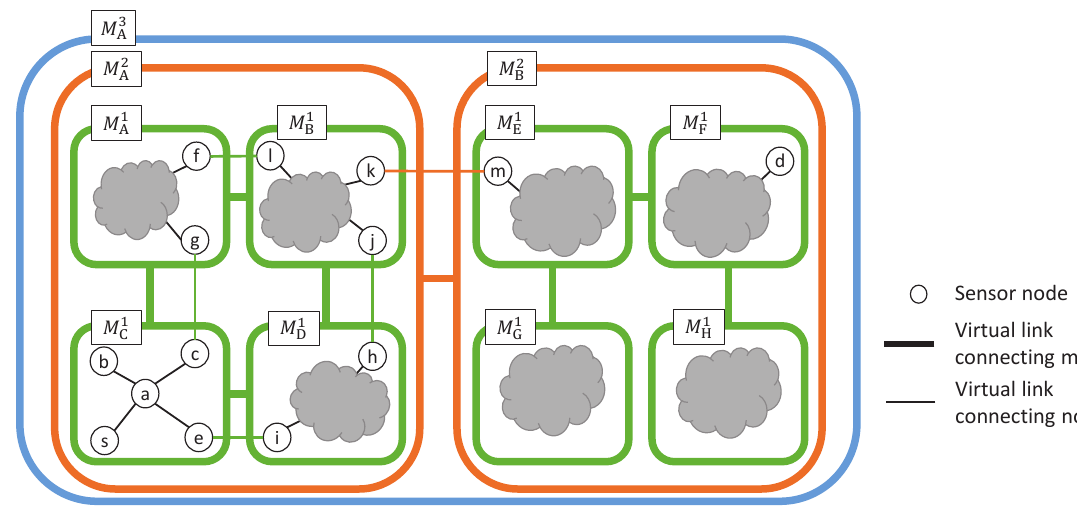
Figure 3. Example of a hierarchical